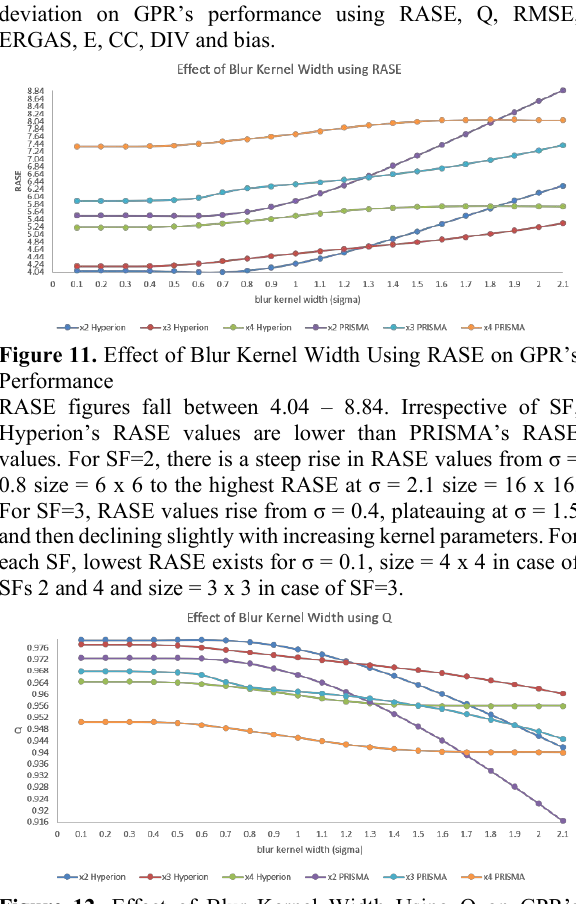
Figure 12. Effect of Blur Kernel Width Using Q on GPR’s Performance